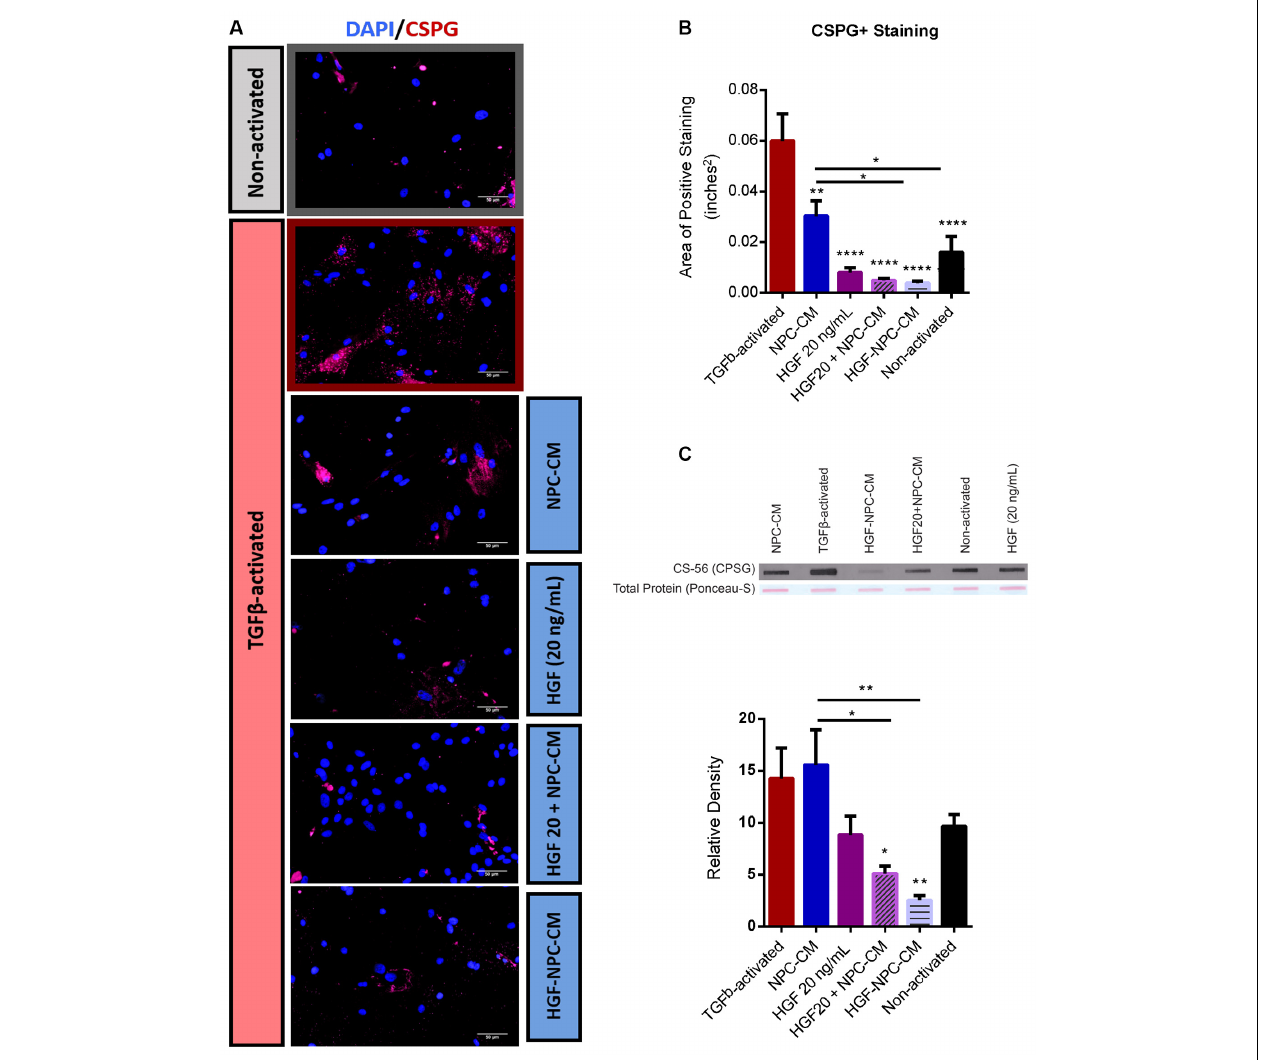
FIGURE 3 | Combinatorial treatment of reactive astrocytes with HGF-enhanced NPC-CM demonstrates reduced CSPG deposition. (A,B) Immunostaining of non-activated and TGF β -induced reactive astrocytes with reactivity marker CSPG (green) and DAPI (blue). TGF β -activated astrocytes demonstrate a significant increase in CSPG expression relative to non-activated astrocytes. All treatment groups demonstrated a significant reduction in CSPG expression relative to TGF β -activated astrocyte controls; Combinatorial treatment (preconditioned and concurrently applied) proved more effective than NPC-CM alone. Data are expressed as mean ± SEM; One-way ANOVA statistical analysis with Tukey’s post hoc test; * p ≤ 0.05, ** p ≤ 0.01, **** p ≤ 0.0001. (C) Slot blot analysis of astrocyte CM probed with CSPG. While treatment of TGF β -activated astrocytes with NPC-CM and HGF alone revealed trending reductions in CSPG expression, only combinatorial treatment (preconditioned and concurrently applied) demonstrated significant reductions. Combinatorial treatment also proved more effective than NPC-CM alone. Data are expressed as mean ± SEM and normalized to ponceau total protein load. One-way ANOVA statistical analysis with Tukey’s post hoc test was performed; * p ≤ 0.05, ** p ≤